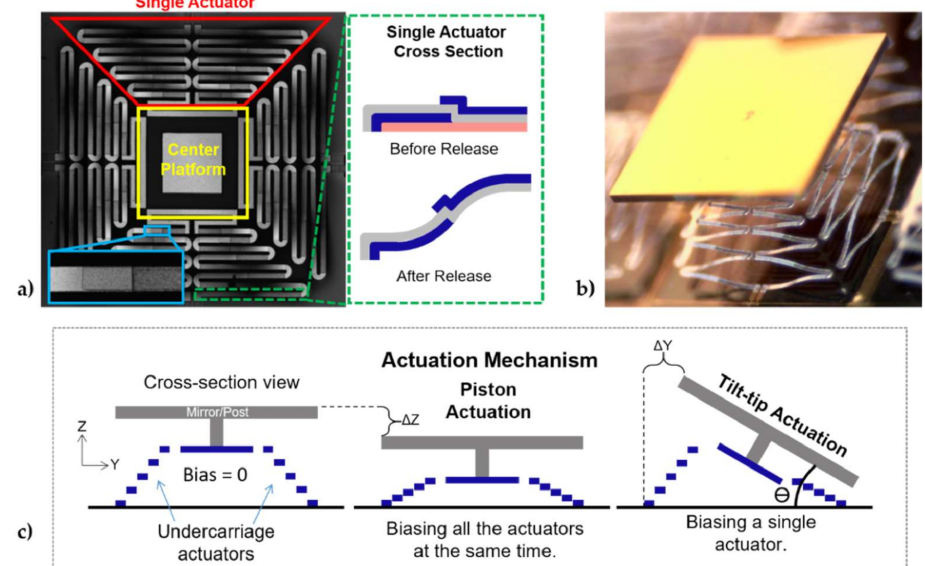
Figure 1. ( a ) Composite image from 3D confocal microscope of the actuation mechanism (undercar- riage) of four actuators connected to a central platform with a footprint of 0.9 mm 2 . The left bottom inset shows the overlap (40 µ m) between the layers on a single beam, and the right inset illustrates a cross-section of the actuators with oxide/metal/oxide layer configuration, ( b ) optical image of the released mirror-bonded device with a 1 mm 2 mirror, and ( c ) representation of the actuation motions of the proposed device. The actuators start with an initial elevation, as the actuators are biased and the temperature is increased, the relaxation of the thermal film stresses from coefficient of thermal expansion (CTE) mismatch generates a downward motion, which results in a displacement towards the substrate. A piston-like motion is created when biasing all four actuators simultaneously with the same amplitude, while a tip/tilt motion is generated by applying a bias to a single